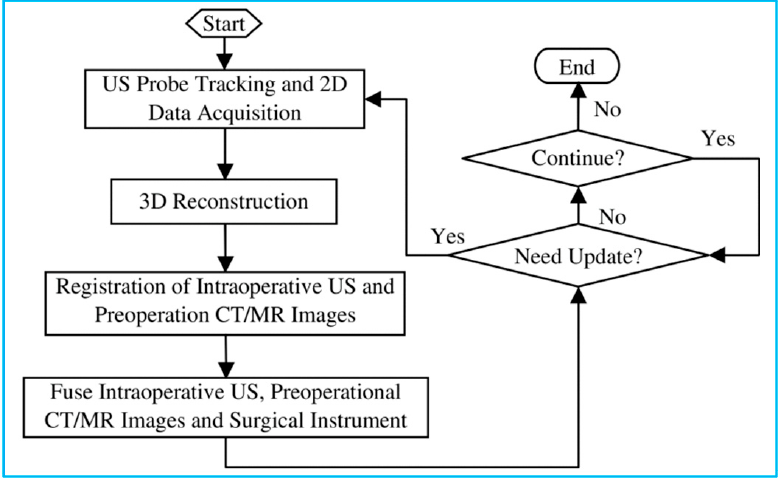
Figure 15. A basic process of 3D US image-guided surgery navigation. Reprinted from [172] with permission.